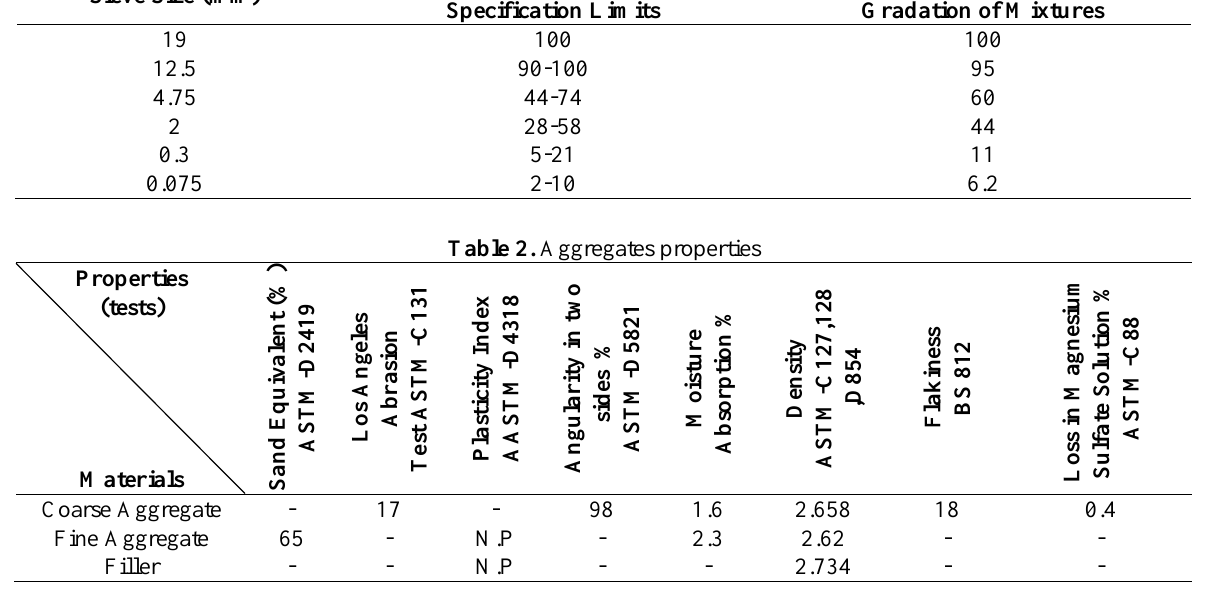
Table 1. Gradation of the mixture aggregates